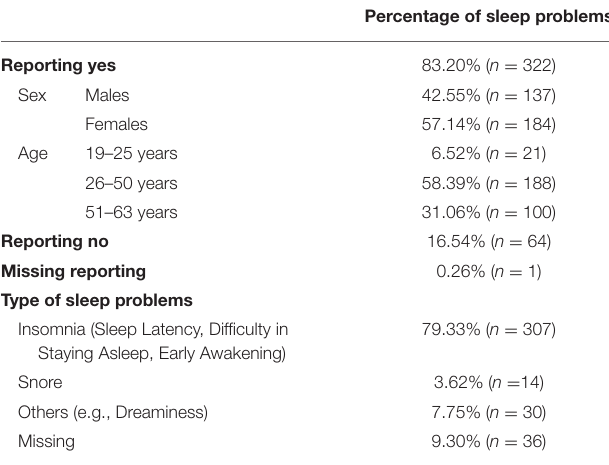
TABLE 2 | Percentages and types of symptoms of sleep problems.